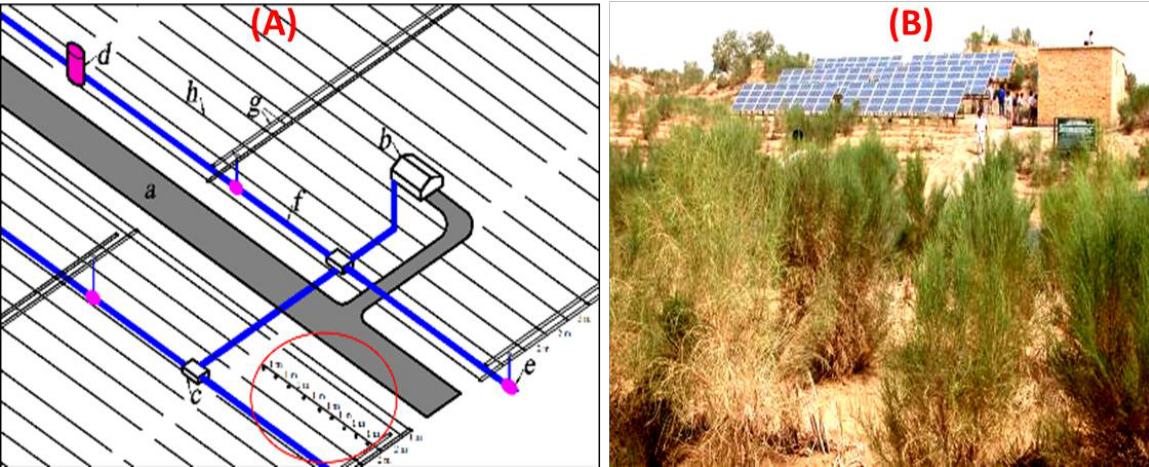
Figure 2. The drip-irrigation system for the Taklimakan Desert Highway Shelterbelt ( A ), which is powered by solar panels in some sections ( B ). (a) Desert highway; (b) well-house; (c) control valve well; (d) connecting well; (e) water valve; (f) main pipe; (g) double-branch pipe; (h) capillary tube. Figure 2 is sourced and updated from [13].